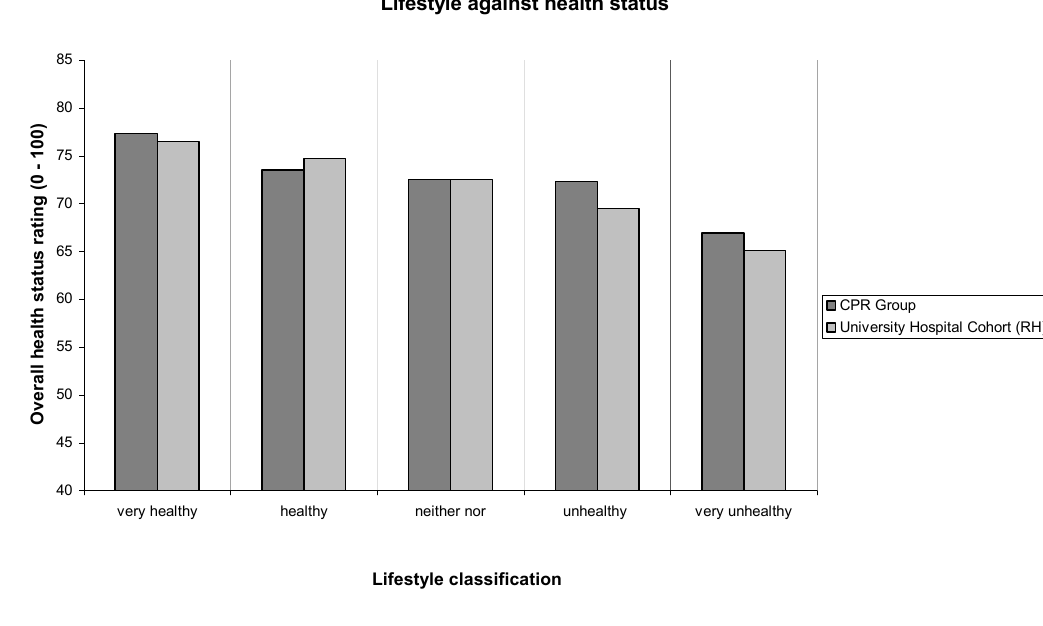
Figure 1 . Lifestyle against health status. The statistical co-variation is about 10% in both studies. This is a far weaker co-variation than is seen between quality of life and health (figure 2), suggesting that global QOL is the most important factor of the two for preventing disease and improving public health.